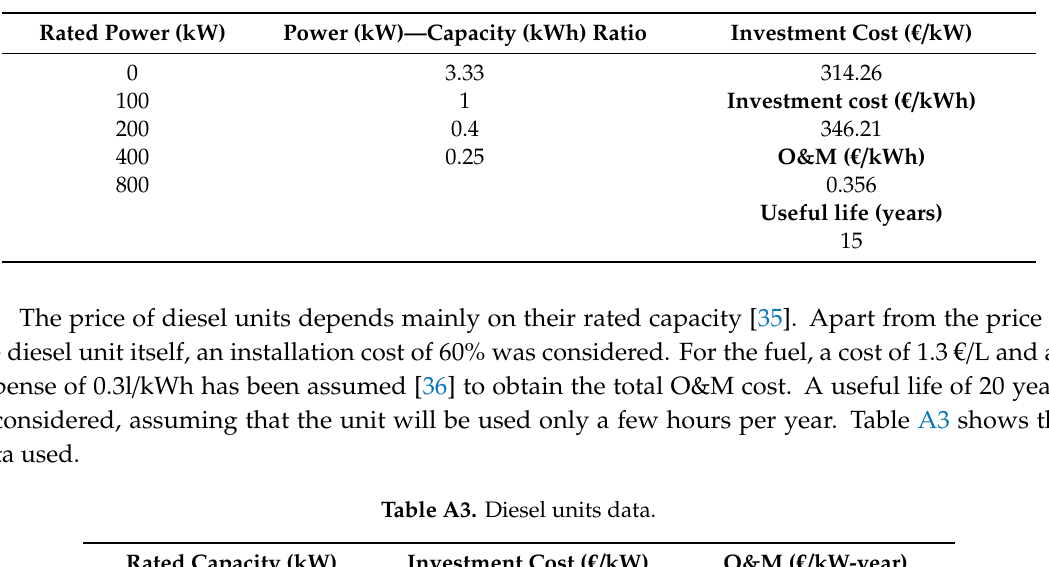
Table A2. Batteries data.